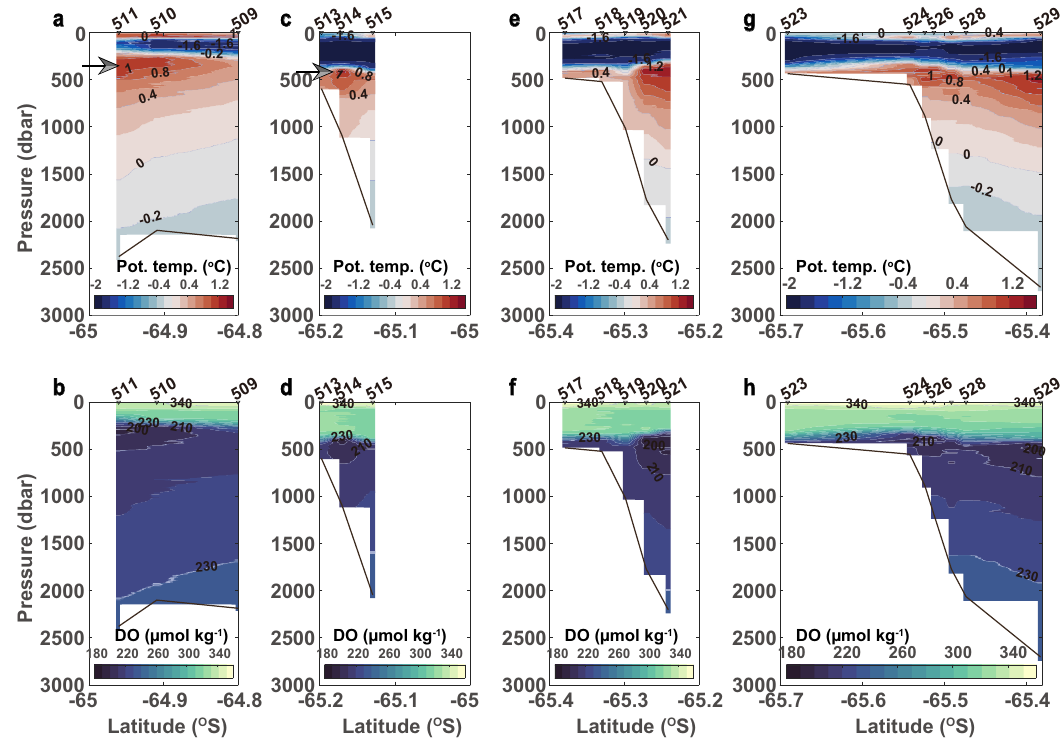
Fig. 5 Warm water distribution from upper slope across shelf break. Closely spaced meridional sections of potential temperature (°C) and dissolved oxygen ( μ mol kg − 1 ) from upper continental slope to shelf break regions at a , b Section 4, c , d Section 5, e , f Section 6, and g , h southern part of Section 3. Arrows in panels a and c represent the locations of warm cores observed around the western half of the West-Sabrina